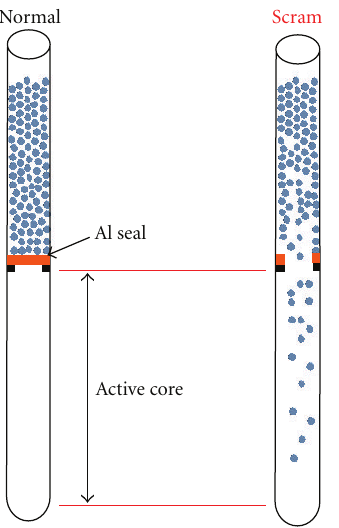
Figure 3: Presented concept for a secondary SCRAM system using absorber spheres and an Aluminum melt